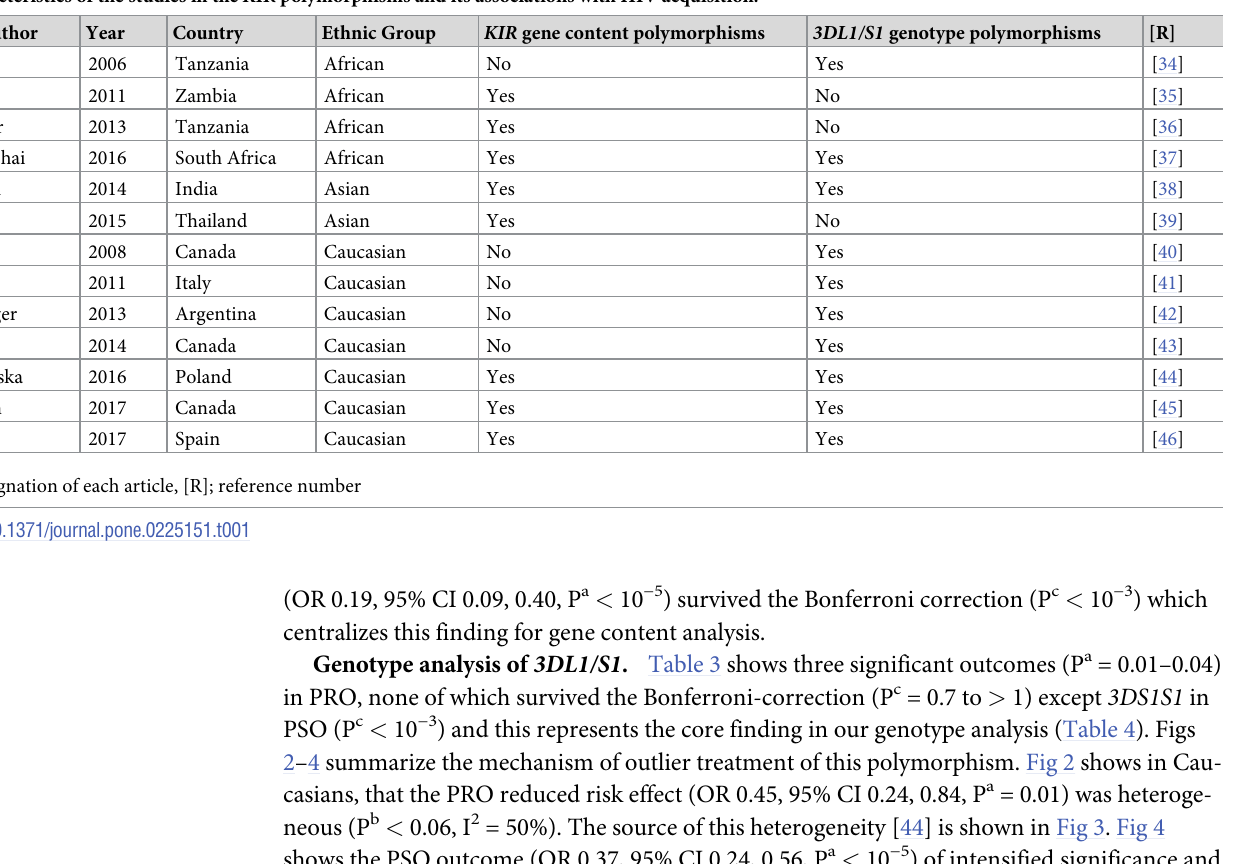
Table 1. Characteristics of the studies in the KIR polymorphisms and its associations with HIV